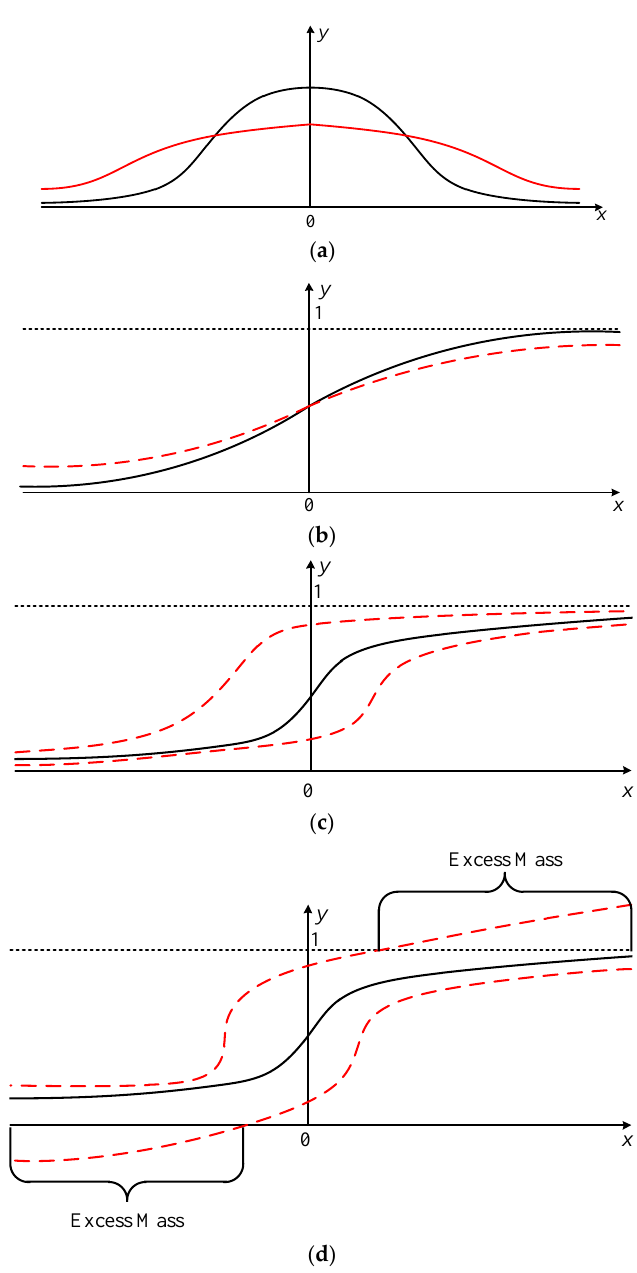
Figure A1. ( a ). Tail overbound. ( b ). CDF overbound. ( c ). Paired overbound. ( d ). EMC paired Figure A1. ( a ) Tail overbound. ( b ) CDF overbound. ( c ) Paired overbound. ( d ) EMC paired overbound.